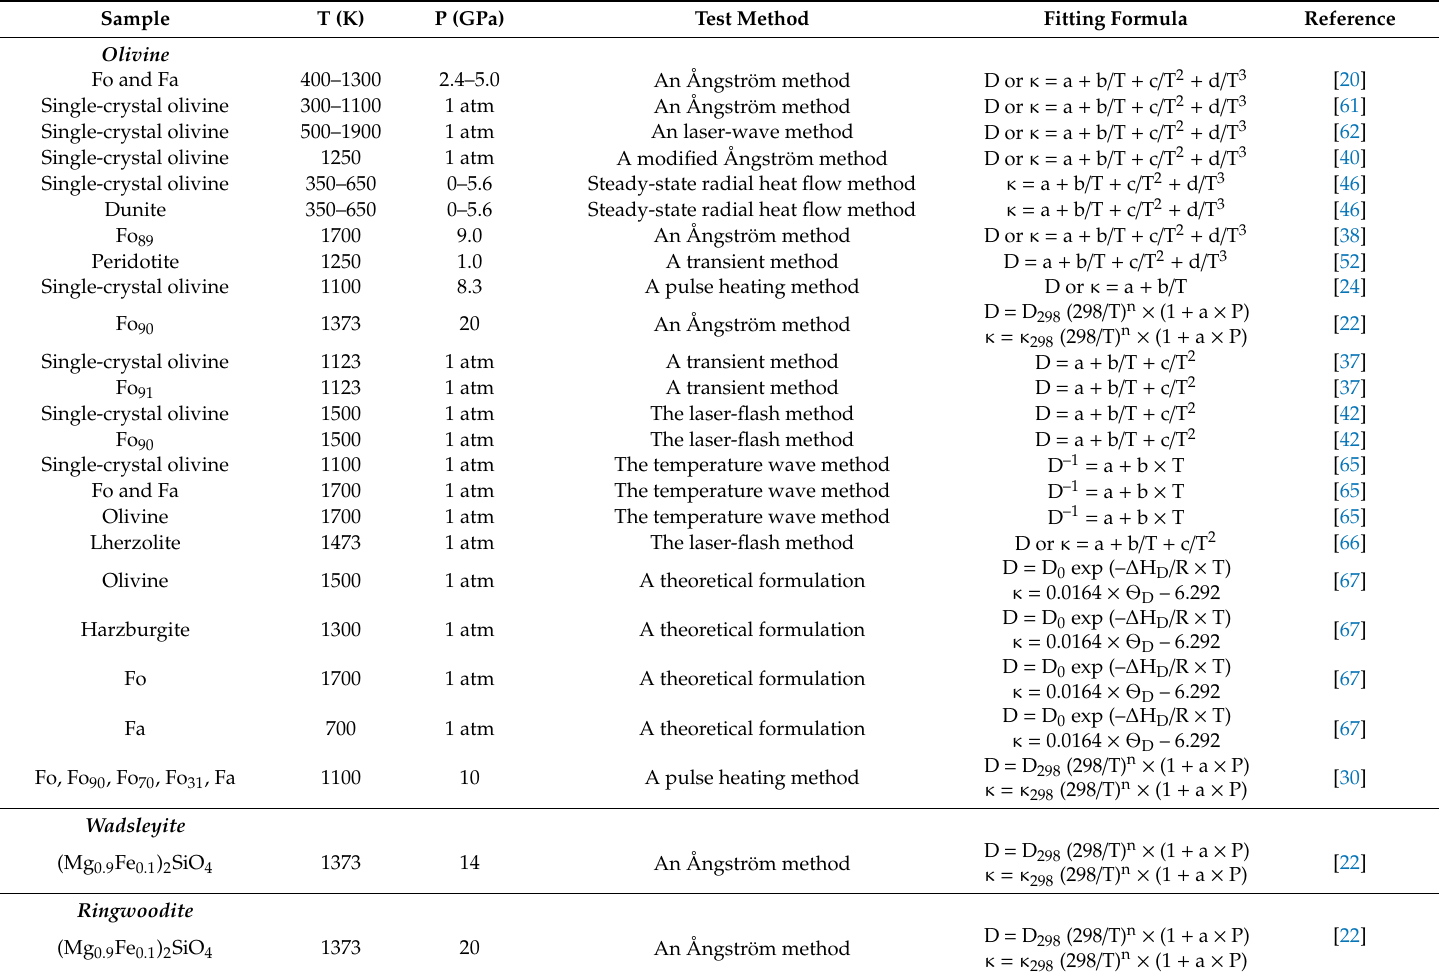
Table 2. Characteristics of the reviewed olivine, wadsleyite, and